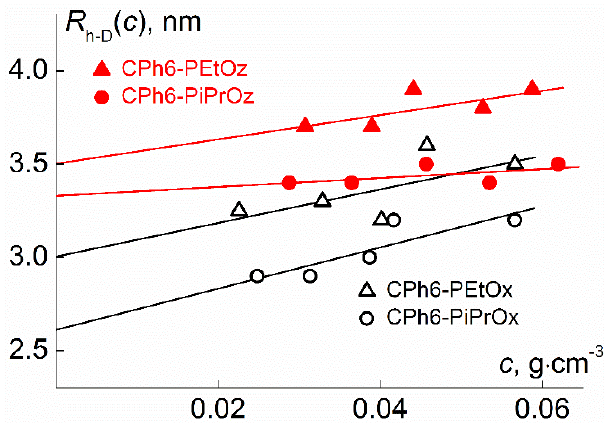
Figure 2. Plots of R h-D ( c ) vs. concentration с for the studied polymer stars in chloroform.